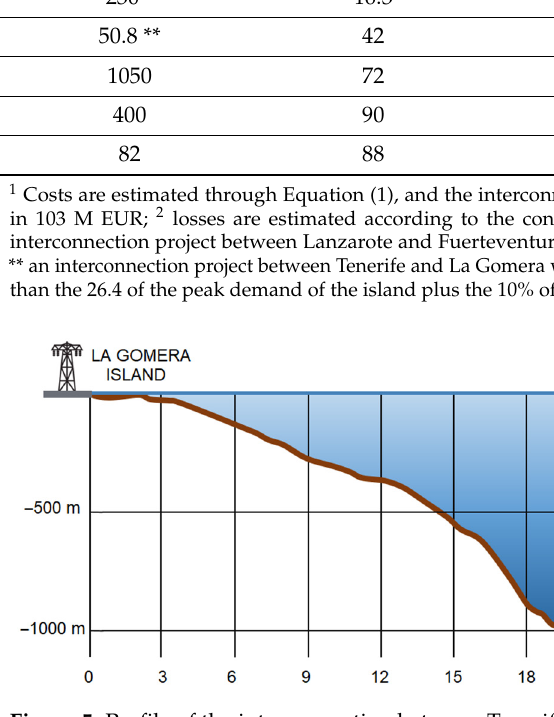
Figure 5. Profile of the interconnection between Tenerife and La Gomera islands in 2040.